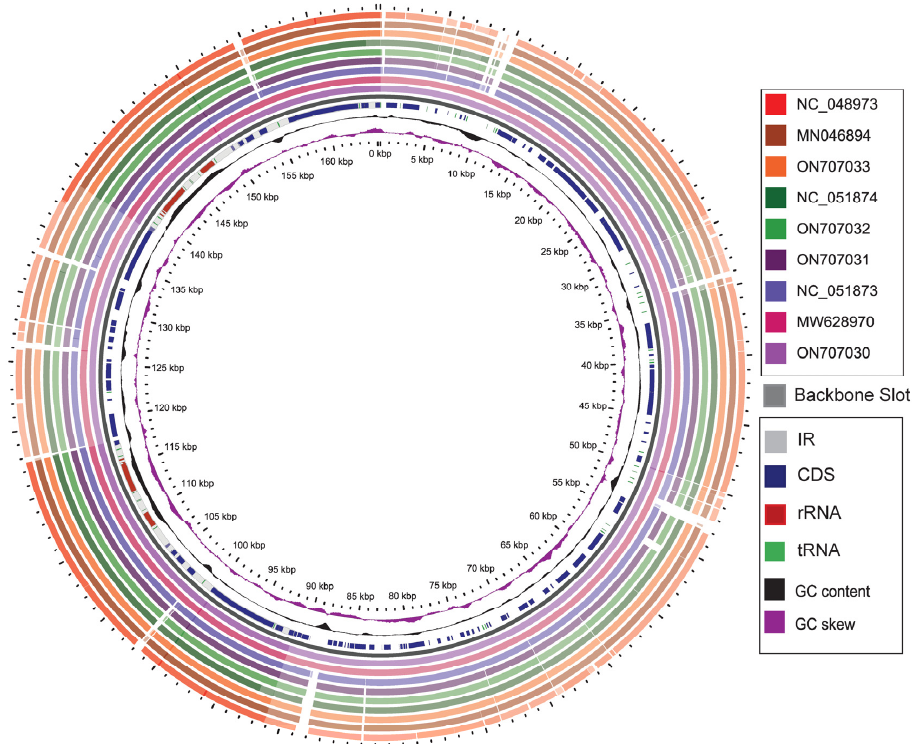
Figure 3. The graphical map shows nine circular plastome assemblies using C. bicolor plastome alignment as a reference. The innermost ring shows the genome size in kbp, followed by GC skew (purple) and GC content (black). From the inner to outer: C. praetermissum (ON707030), X. sagittifolium (MW628970), X. helleborifolium (NC_051873), C. bicolor (ON707031), C. humboldtii (ON707032), Z. amazonica (NC_051874), C. lindenii (ON707033), S. angustatum (MN046894), Z. zamiifolia (NC_048973). The similar and divergent locations are represented by continuous and interrupted track lines, respectively.